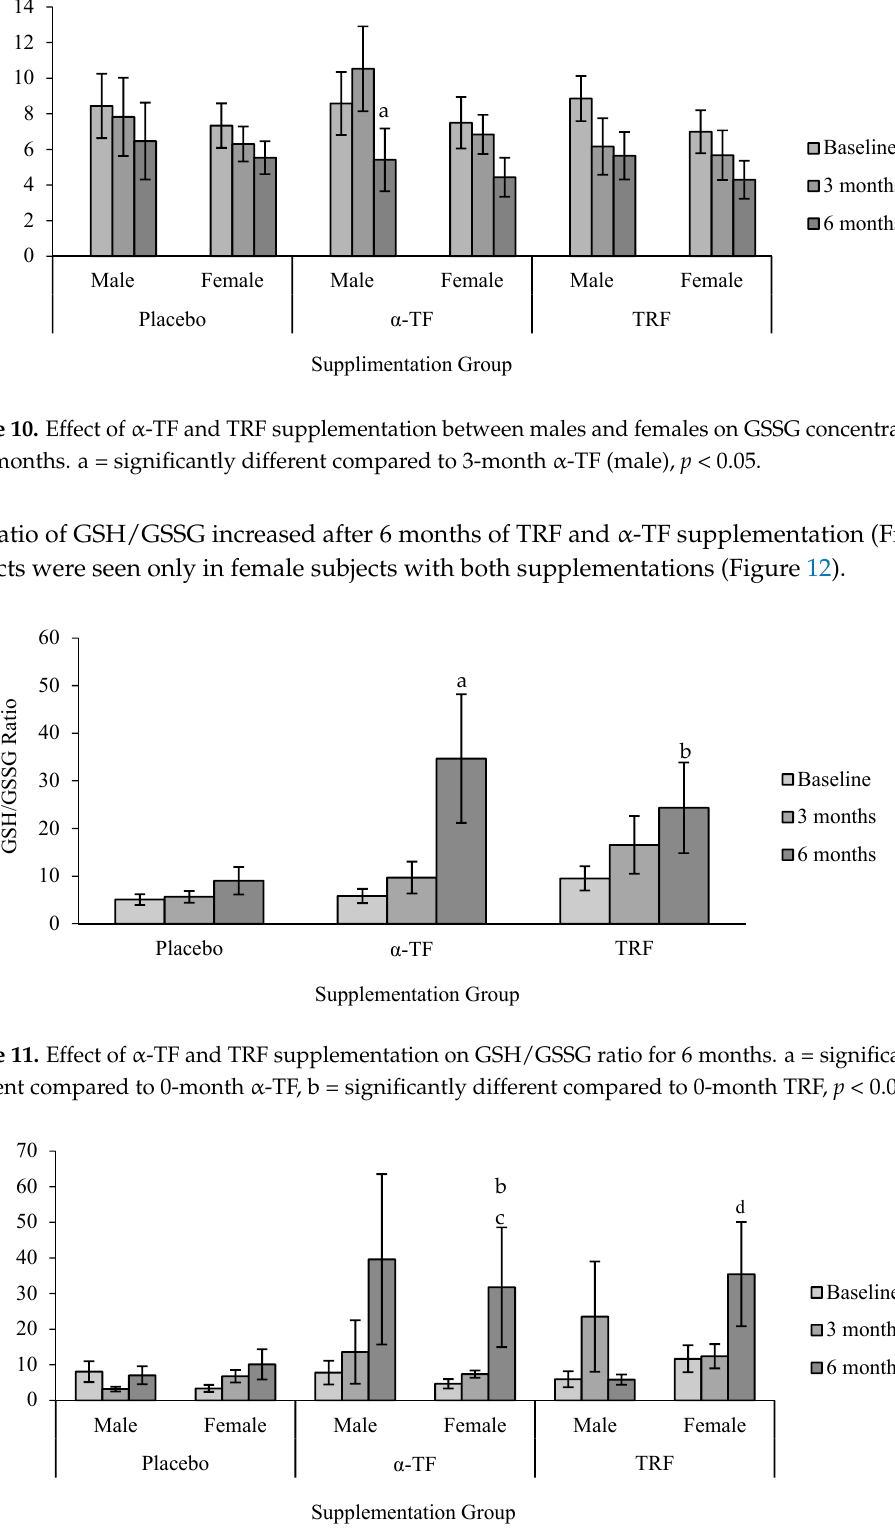
to 3 months α -TF, c = significantly different compared to 0 month TRF, p < 0.05.